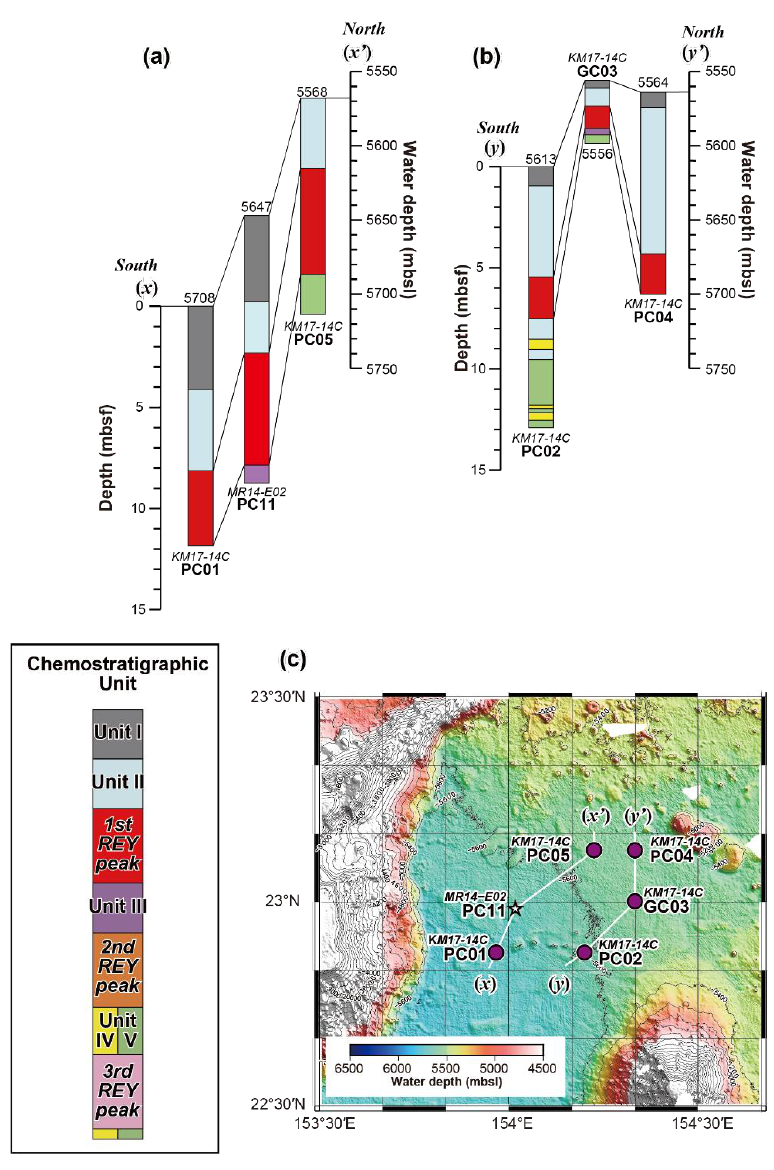
Figure 6. Chemostratigraphic correlation east of Takuyo Daigo Seamount along the cores ( a ) in the west (x–x′) and ( b ) in the east (y–y′), and ( c ) detailed map east of Takuyo Daigo Seamount. The vertical positions correspond to their water depth (meters below sea level; mbsl) on the right scale. Their core lengths (meters below sea floor; mbsf) correspond to the left scale.